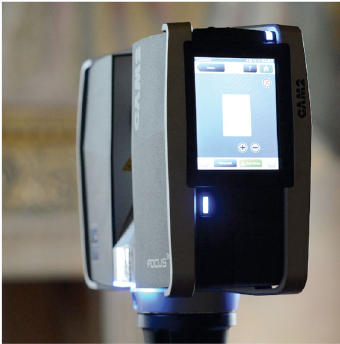
Figure 7. Laser scanner CAM2, FARO FOCUS 3D - MINOLTA VIVID 9i, a triangulation based laser scanner, used to perform a high accuracy survey of the crack in the Camera degli Sposi.